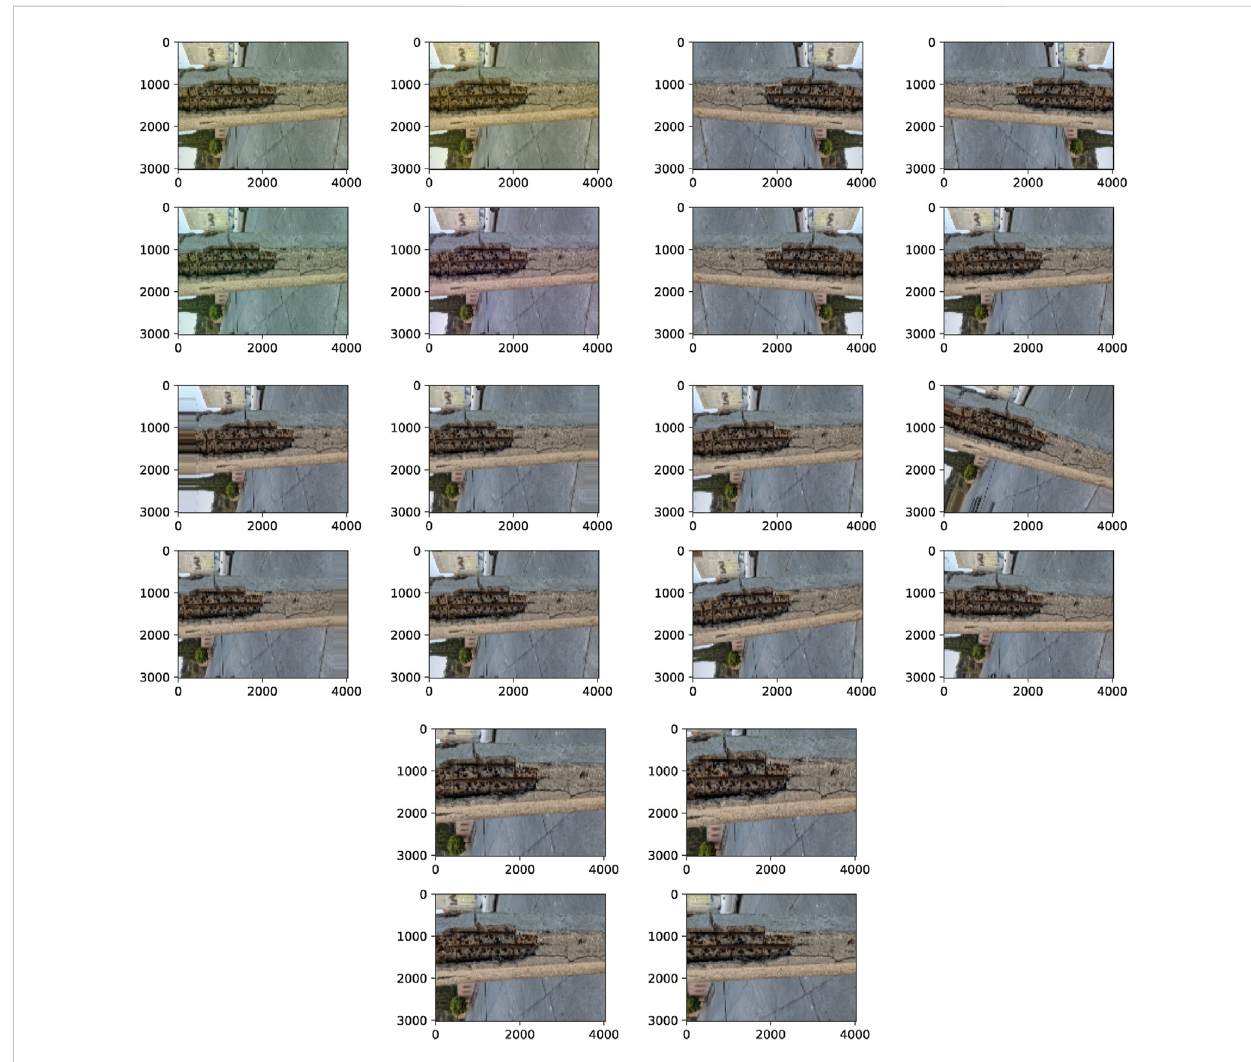
FIGURE 8 Data augmentation representation in a sample image with different